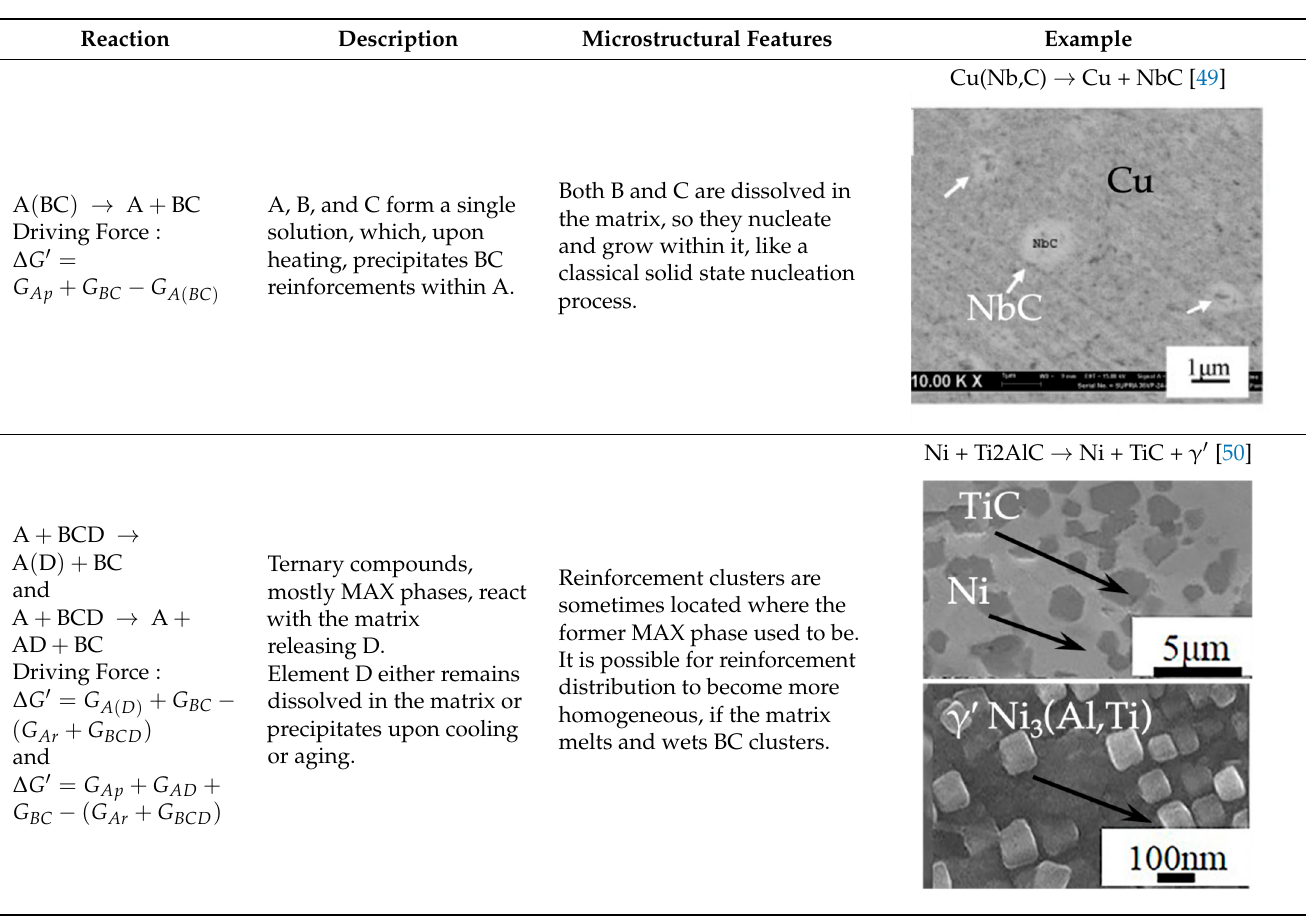
Figure 7. Microstructural evolution of raw material possibilities for composites of type A + BC. The pictures in the first column correspond to the beginning of the reaction (t = 0), the second column to an intermediate state of the process, and the third column to the system’s final